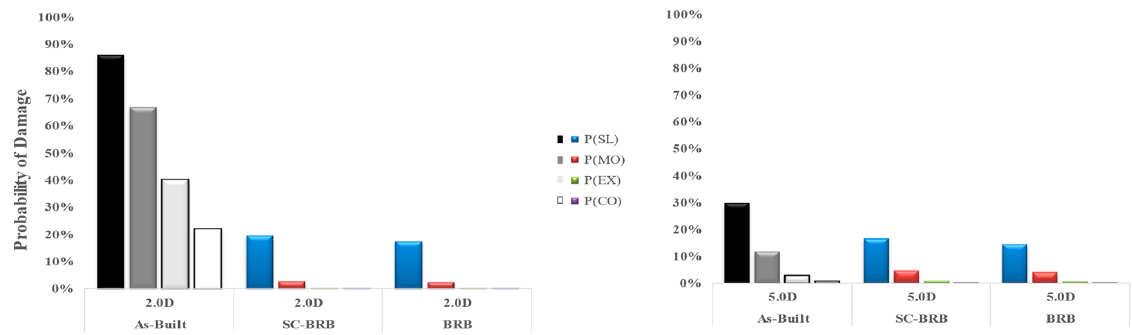
Figure 29. Limit state exceedance probabilities (LSEPs) of CD demands under far-field ( left , at 2D) and near-source ( right , at 5D) earthquake records.